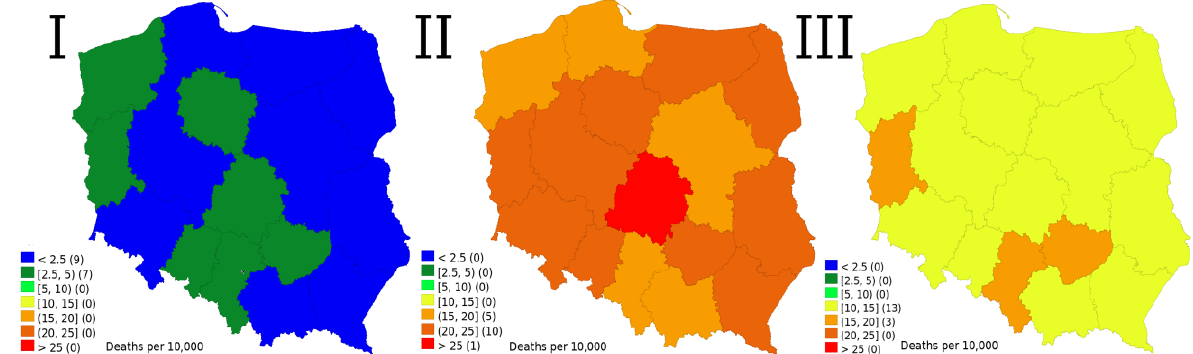
Figure 2. Excess mortality rate during the three waves of COVID-19 pandemic in Poland per 10,000 people; I — 1st wave, II — 2nd wave, III — 3rd wave; data source: Statistics Poland